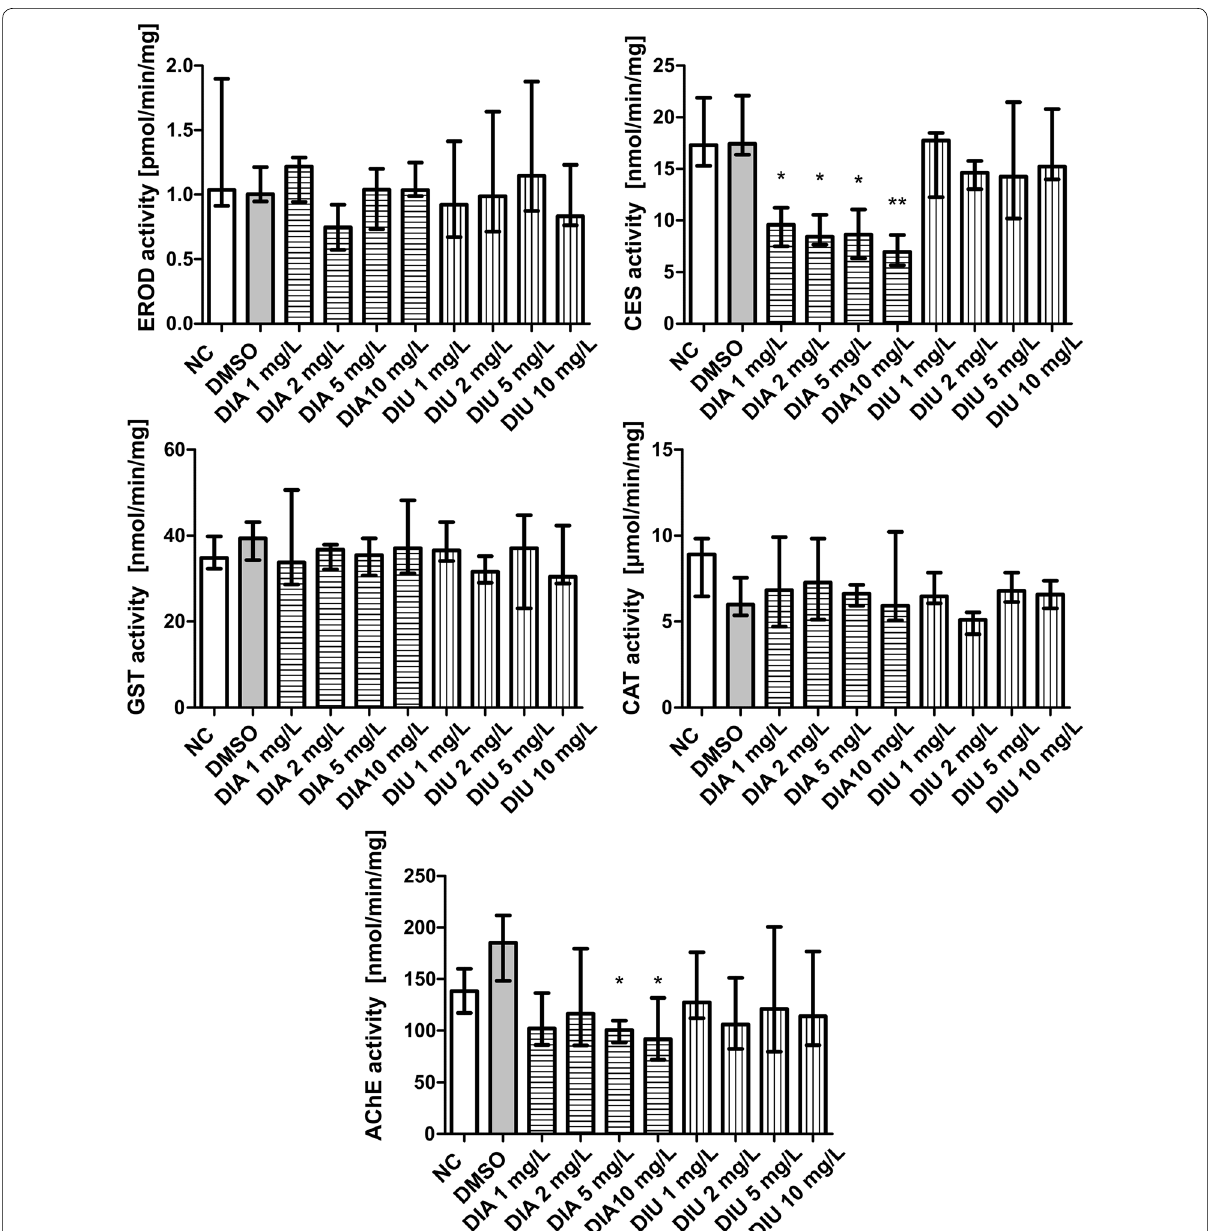
Fig. 5 Enzymatic biomarker responses in zebrafish larvae (96 hpf) exposed to diazinon and diuron for 1 h. NC: negative control; DMSO: solvent control, 0.1% DMSO; DIA: diazinon; DIU: diuron. Bars represent medians with interquartile range of five repeated experiments (40 larvae pooled into one sample per condition in each repetition). Analyses were made in comparison to the DMSO solvent control condition and significant differences are labeled with * p < 0.05 and ** p <